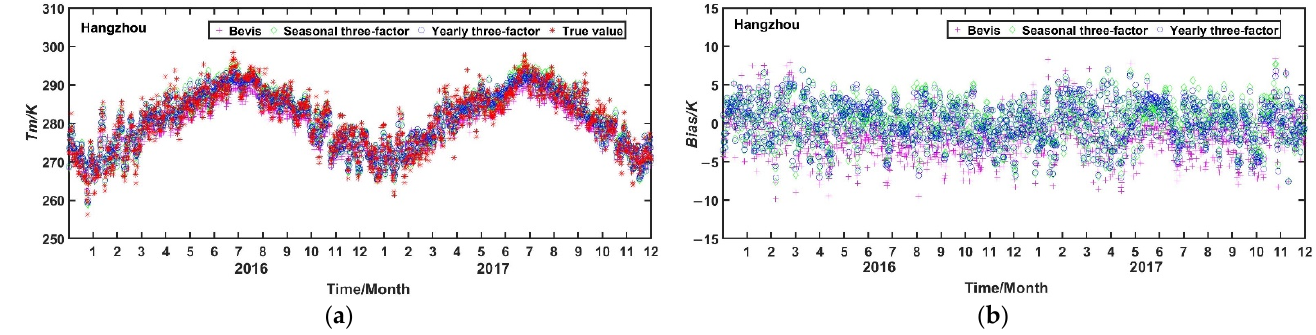
Figure 7. Time series of T m ( a ) and biases ( b ) of Bevis, the yearly and seasonal three-factor RTMs to the radiosonde-derived T m at Nanjing station during 2016–2017.